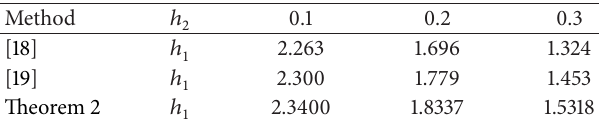
Table 1: Admissible upper bound ℎ 2 for various ℎ 1 . Table 2: Admissible upper bound ℎ 1 for various ℎ 2 .